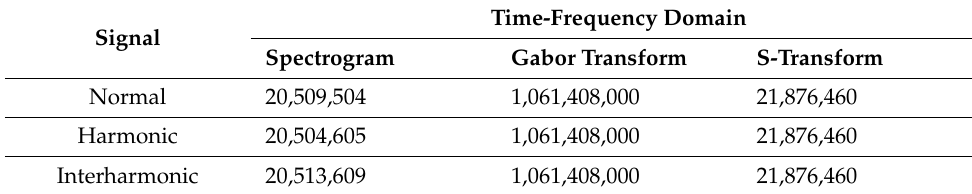
Table 3. The MAPE of the computational complexity of the analysis.